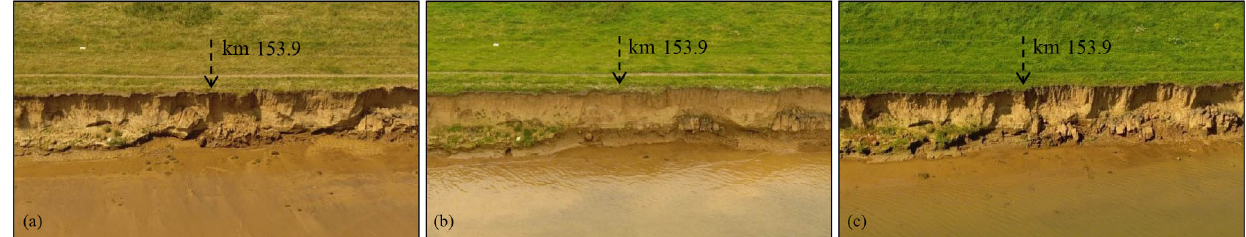
Figure 13. Zoomed-in UAV photos from track 1 at section 4, kilometre 153.9, showing diverse bank erosion stages: slump blocks at bank toe on 21 June (a) , clean bank face after block removal on 19 July (b) , and undermining on 23 August (c)